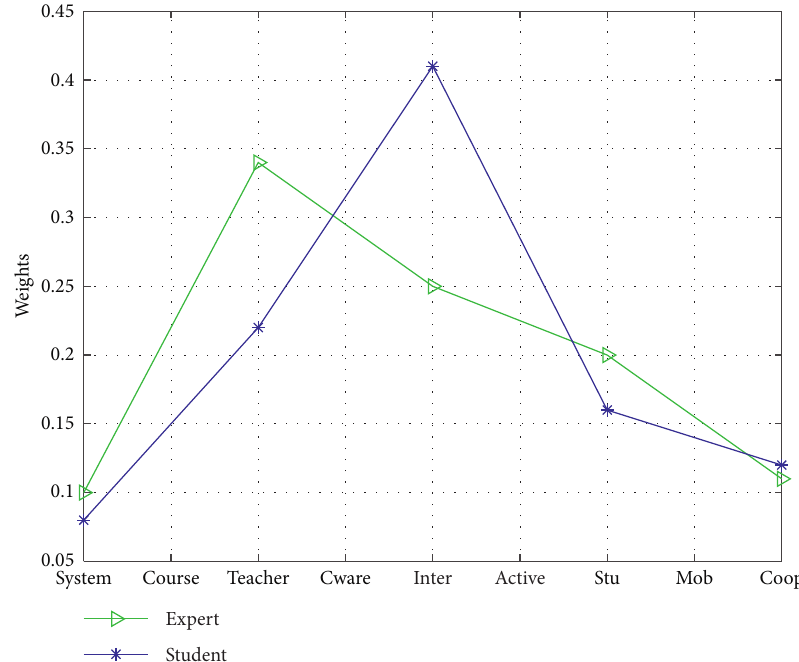
Figure 4: Comparison of the first-level indicator empowerment results of experts and